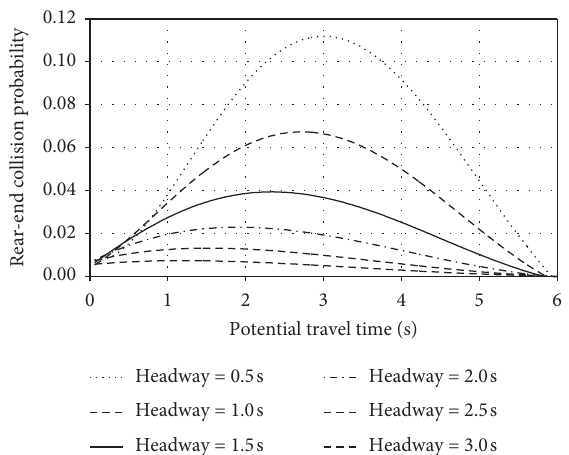
Figure 5: Probability of rear-end collisions with different headway.